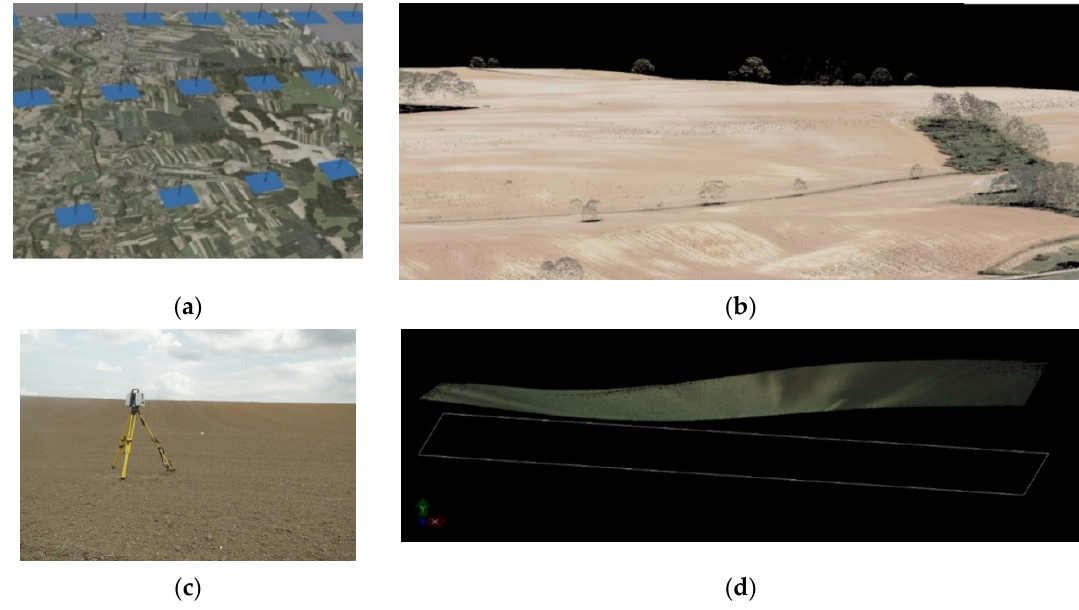
Figure 2. Analysed fragments of point clouds from: ( a ) aerial photographs, ( b ) aerial laser scanning, ( c ) Terrestrial Laser Scanning (TLS), ( d ) part of point cloud from TLS.